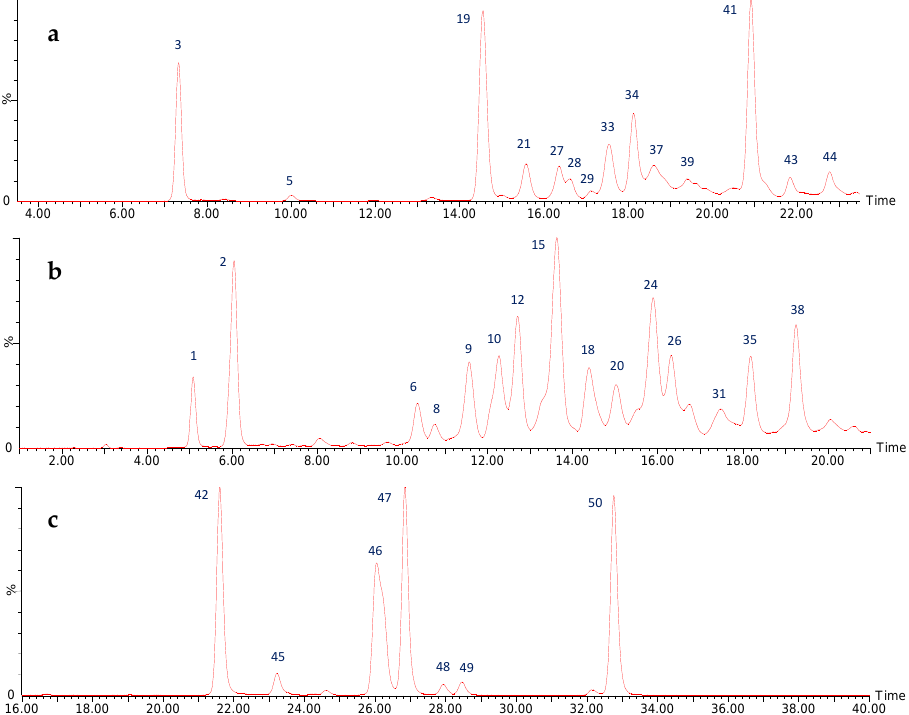
Figure 6. UPLC-QTOF-ESI MS chromatograms of ( a ) properlagonidin (epi)afzelechin-(epi)afzelechin-(epi)afzelechin and (epi)afzelechin-(epi)afzelechin-(epi)catechin B-trimers, ( b ) properlagonidin (epi)afzelechin-(epi)catechin-(epi)catechin B-trimers and procyanidin (epi)catechin-(epi)catechin- (epi)catechin B-trimers, and ( c )